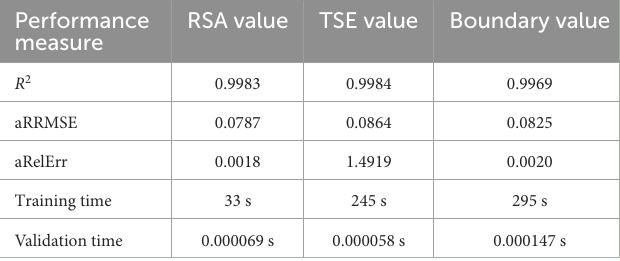
TABLE 1 Performance of the neural networks.